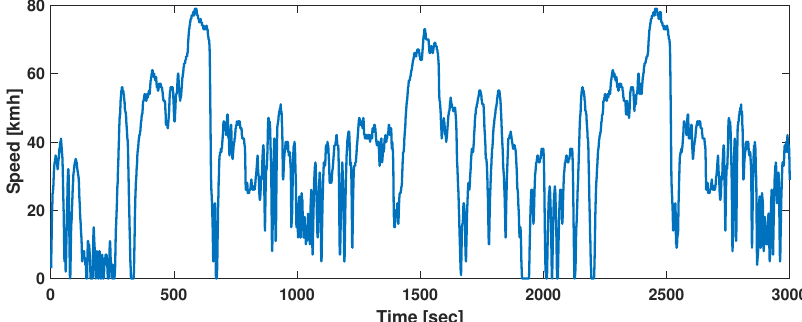
Figure 11. Route3: high energy consumption in mountainous